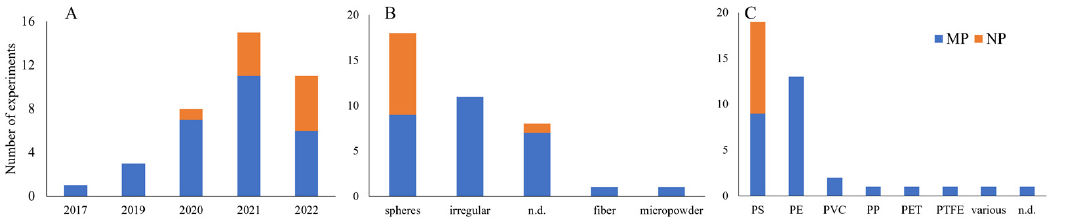
Figure 2. ( A ) Number of experiments per year, ( B ) shape, and ( C ) polymer type of microplastics (MP) and nanoplastics (NP) from the 28 publications selected. N.d.: not determined; PS: polystyrene; PE: polyethylene; PVC: polyvinyl chloride; PP: polypropylene; PET: polyethylene terephthalate; and PTFE: